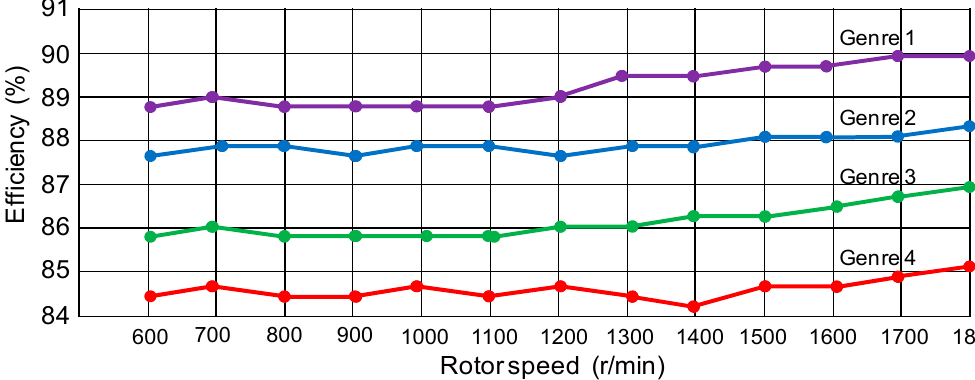
Figure 6. Line chart of comparisons of power factor for 4 kinds of six-phase synchronous reluctance motors mounted to centrifugal compressor with various speeds. Figure 7. Line chart of comparisons of output torque for 4 kinds of six-phase synchronous reluctance motors mounted to centrifugal compressor with various speeds.